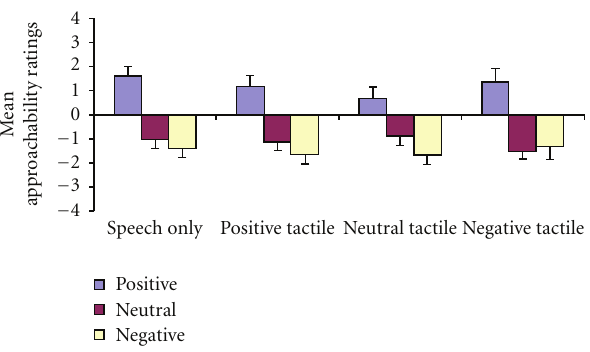
Figure 9: Means and SEMs for the ratings of the stimulus approachability.